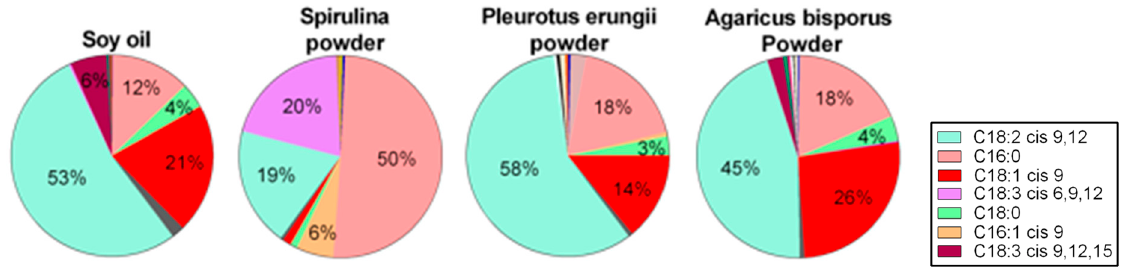
Figure 6. Fatty acid profiles. Lipids were analyzed by gas chromatography–mass spectroscopy.